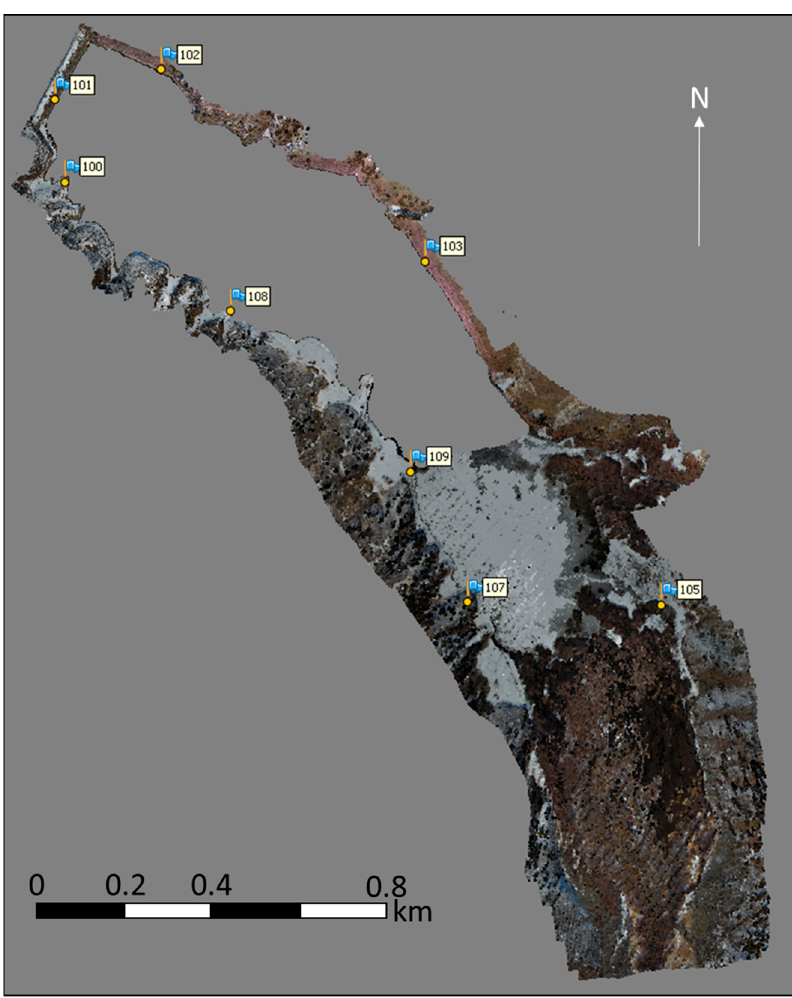
Figure 4. Newcastle Reservoir Model: top view with ground control points shown as flags.